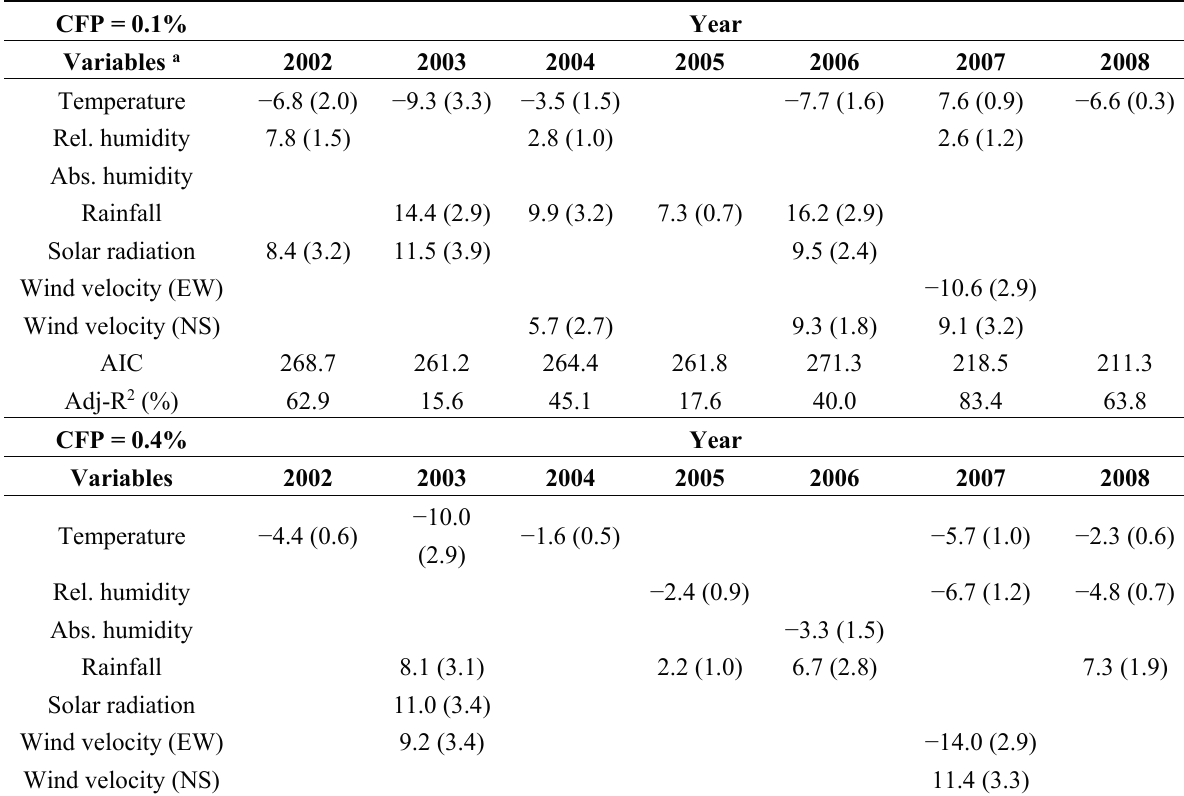
Figure 5. Best fitted curves for GI = 5 days, 3 days, and 7 days. Table 2. Estimates (standard error) of significant meteorological determinants on changes of influenza transmission rate when CFP = 0.1% or CFP = 0.4%. CFP =